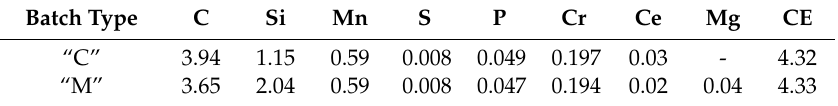
Table 1. Chemical composition of the investigated samples in wt% (CE: carbon